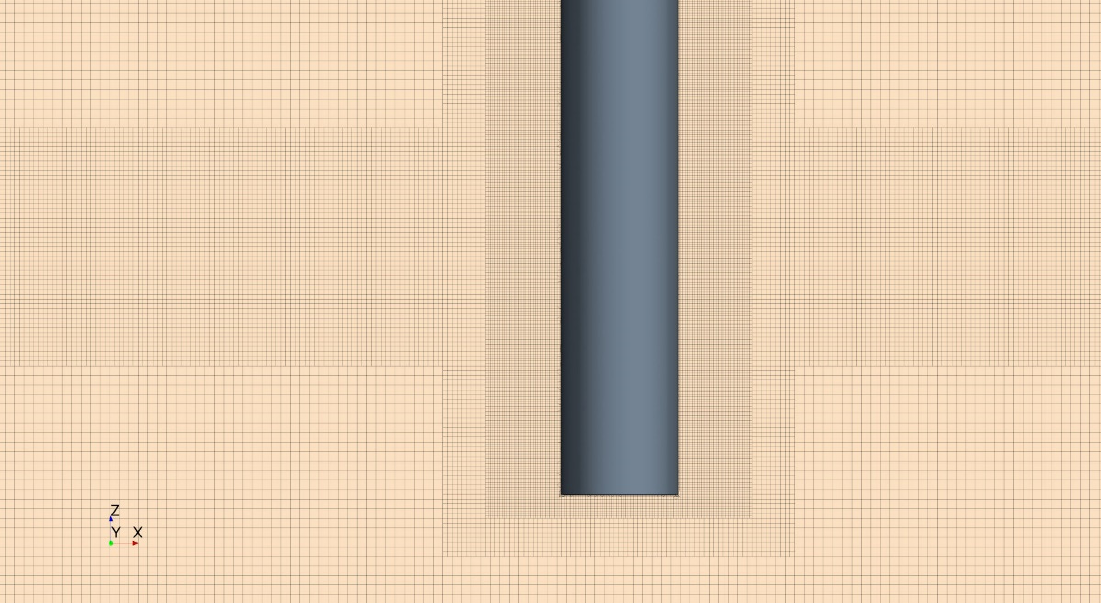
Figure 1. Side view of grid refinement in the vicinity of the large cylinder and at the free surface.